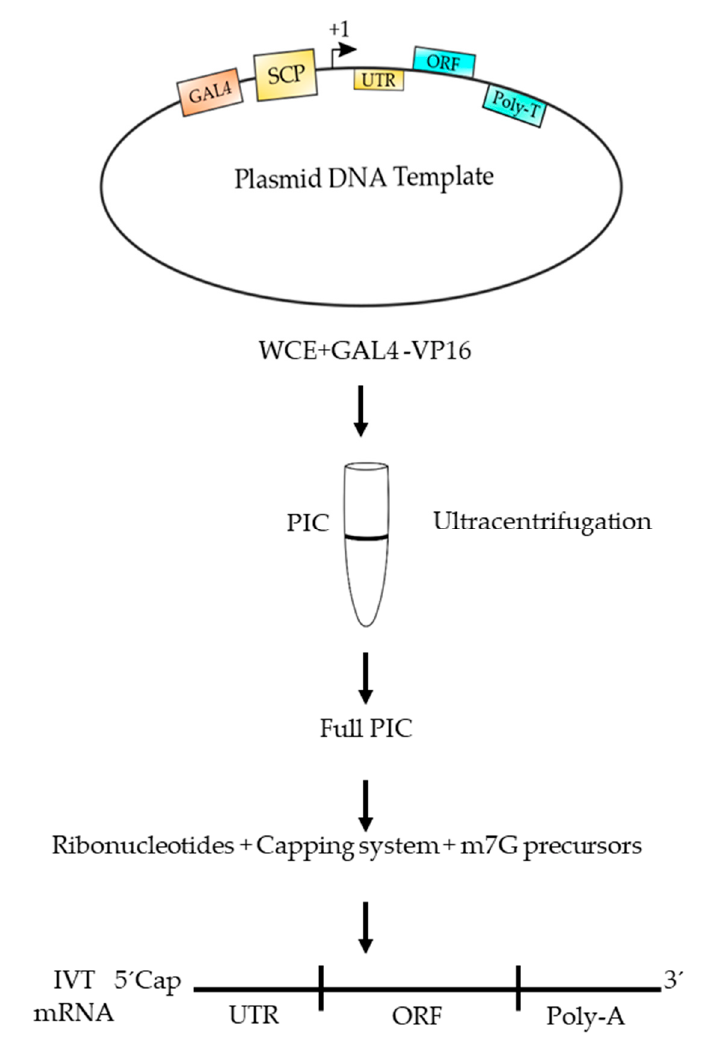
Figure 7. Outline of a procedure to produce a functional mRNA using eukaryotic RNAPII. The plasmid DNA template contains a super core promoter (SCP) and an upstream GAL4 binding site. Transcription starts at the + 1 site, which is followed by an UTR (untranslated region) and an ORF containing the coding region to produce the polypeptide chain. A poly T tail is included in the template to produce a poly adenylated mRNA. The template is mixed with a highly active whole cell extract (WCE) from fission yeast, plus GAL4-VP16 activator and subjected to ultracentrifugation through a glycerol gradient (5–15%). Afterwards, those templates containing a fully assembled PIC are selected and used for transcription by adding ribonucleotides, together with methyltransferase and capping enzymes (capping system) plus the necessary precursors to form a m7G cap. The produced mRNA can be used as an mRNA vaccine.